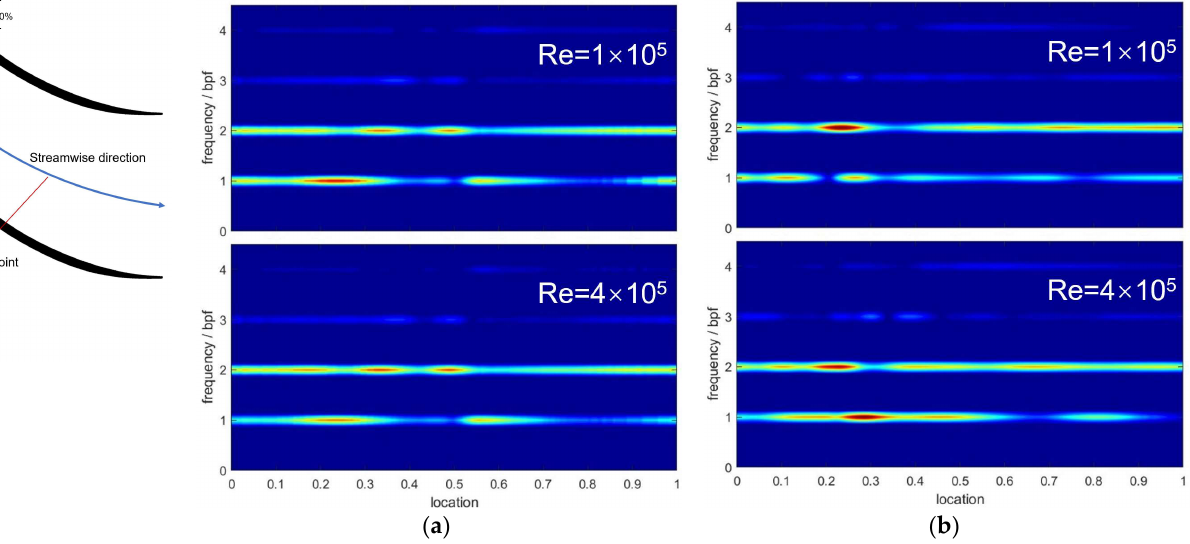
20 of 25 Figure 20. Amplitude of pressure fluctuation on the rotor surface at 99% span.